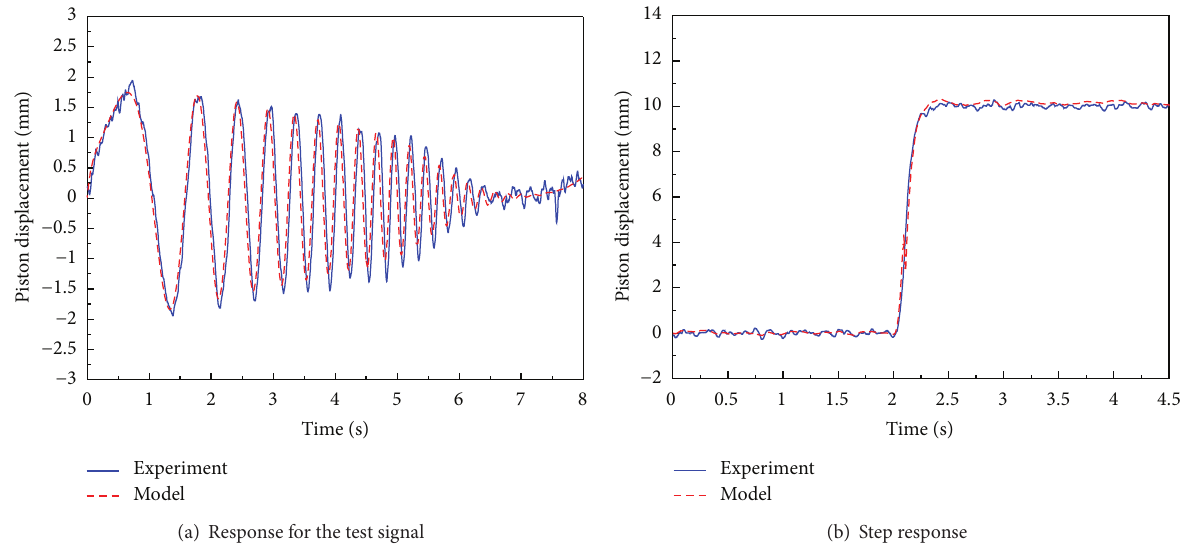
Figure 6: Time responses of the position control system obtained by the experiment and nominal model.